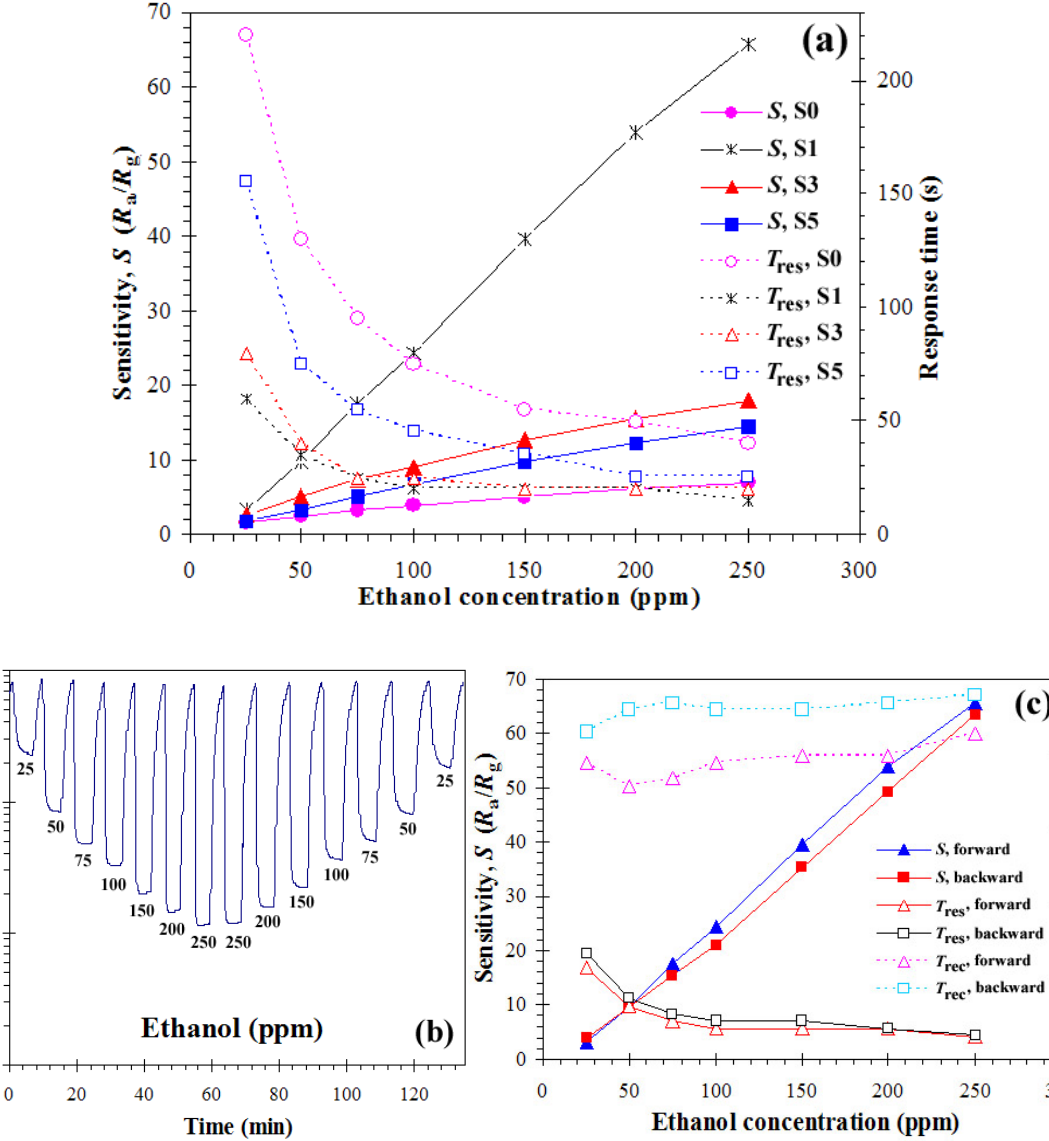
/N at 400ºC. Response times ( T , solid line, 2 2 res , dashed line, right rec